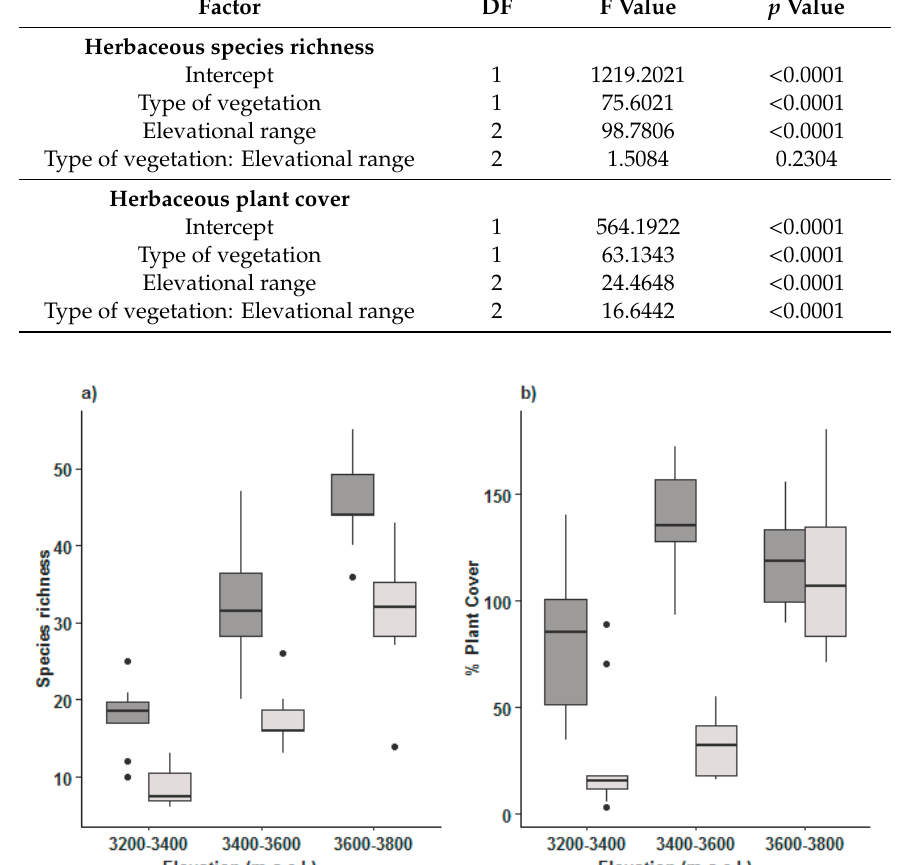
Table 2. Influence of elevational range and type of vegetation on species richness and percentage of plant cover of herbaceous vegetation according to the ANOVA analysis obtained from the linear mixed model (LMM).